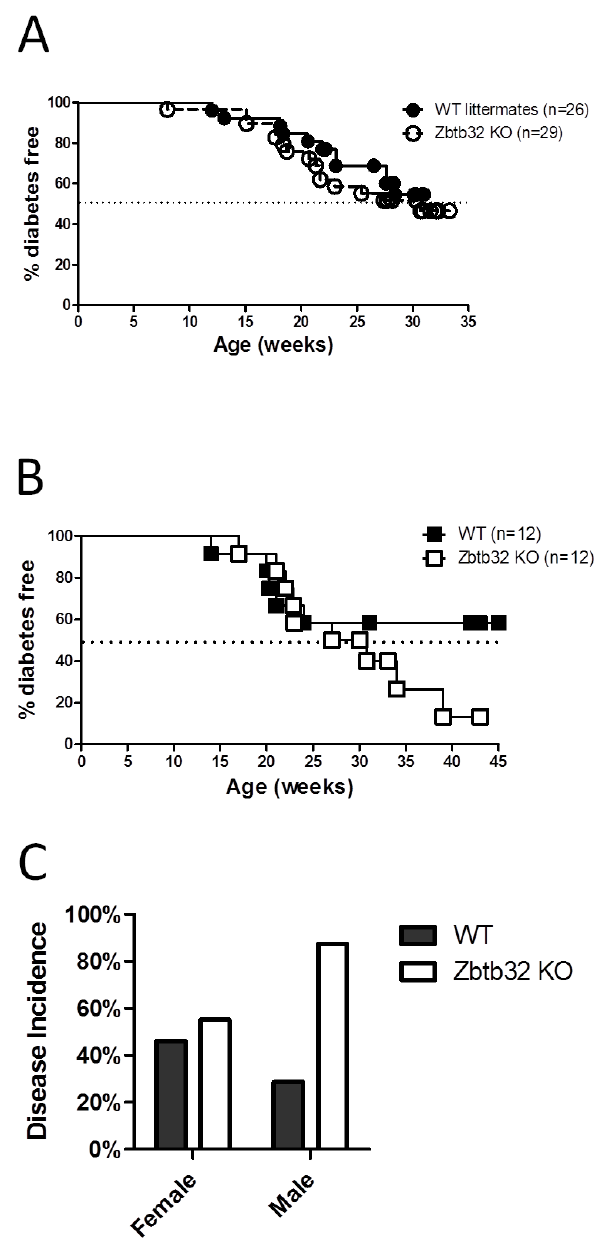
Figure 2. Diabetes incidence in NOD.Zbtb32 -/- mice. The onset of Type 1 diabetes was monitored in our NOD.Zbtb32 -/- colony by weekly blood glucose monitoring for both female ( A ) and male ( B ) mice. Disease incidence rates were followed for littermate wildtype, and homozygous knockout mice. Disease incidence rates for males and females were plotted in ( C